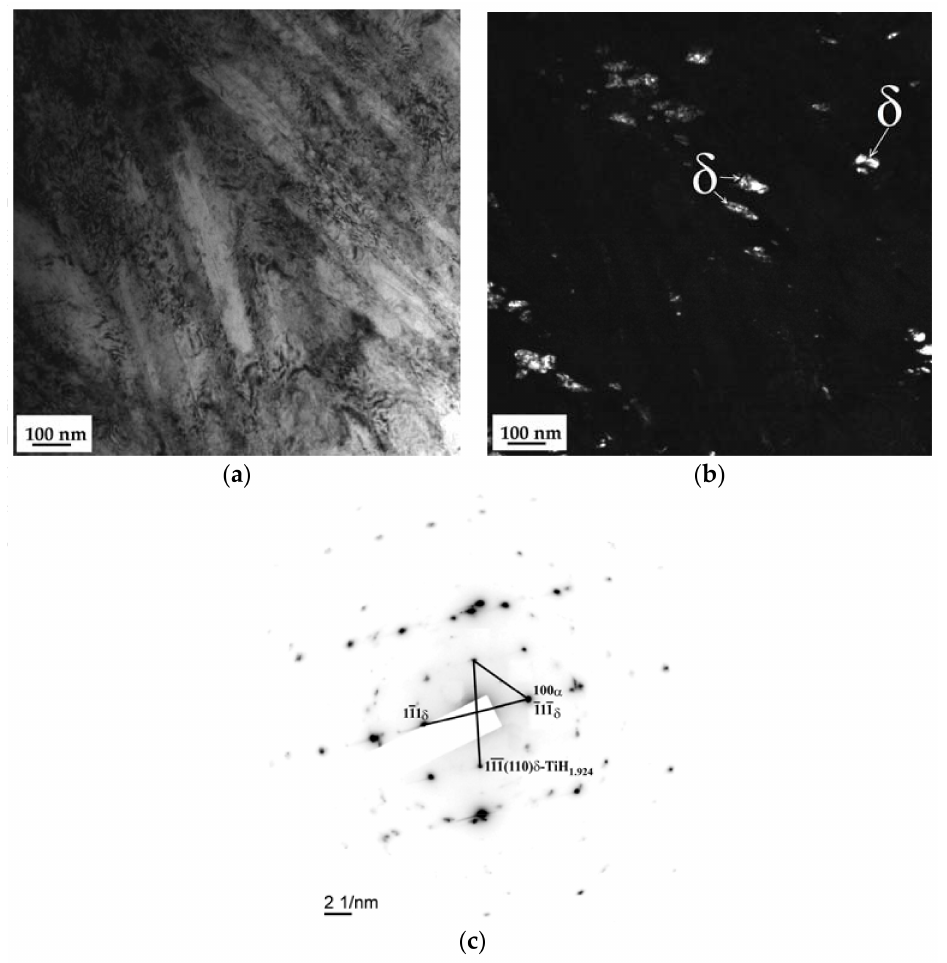
Figure 9. TEM bright- ( a ) and dark-field images ( b ) and associated SAED pattern ( c ) of the microstructure of EBM titanium Ti-6Al-4V parts after hydrogenation to 0.9 wt. %. The dark-field image obtained with 111 δ -TiH